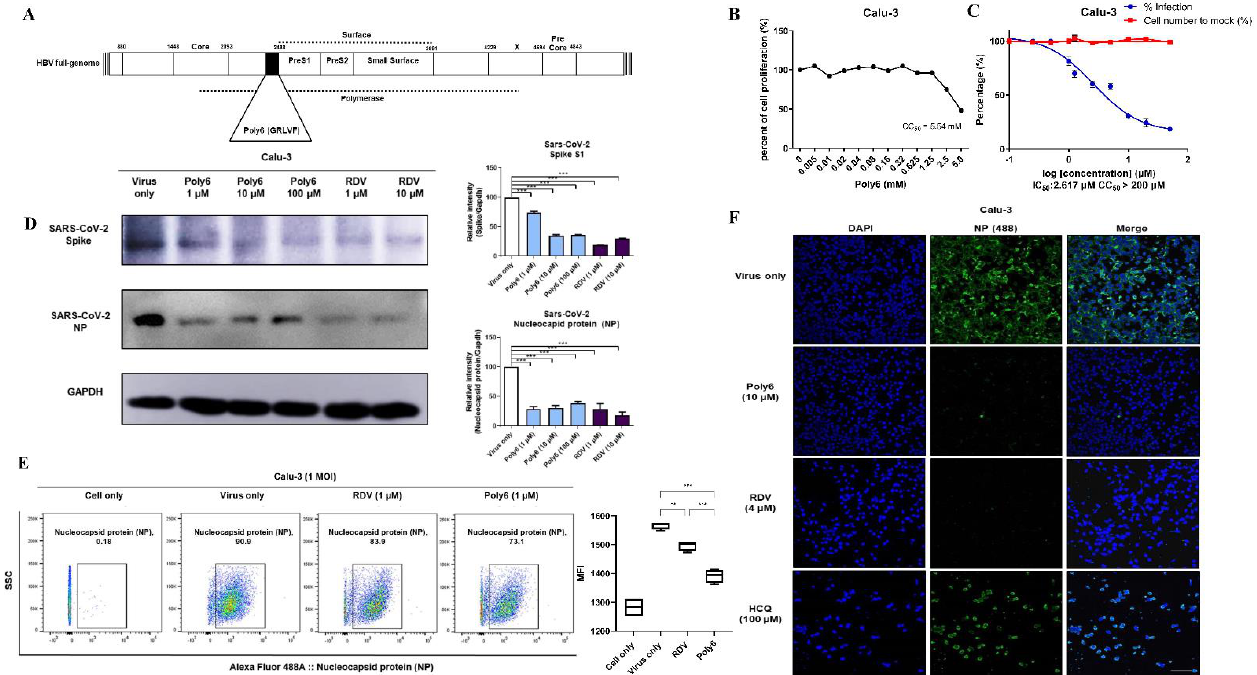
Figure 1. Poly6 inhibits SARS-CoV-2 infection in human lung cell, Calu-3 but not in Vero-E6 cells in a dose-dependent manner. ( A ) Map of Poly6 from the HBV full genome diagram in this study. Poly6 is originated from overlapping HBV polymerase gene regions corresponding to the preS1 deletion region found in patients with severe liver disease. ( B ) Calu-3 cell viability after treatment with different doses of Poly6 was measured using the MTS assay. ( C ) Percent inhibition of SARS-CoV-2 replication and cytotoxicity in Calu-3 cells. Calu-3 cells were infected in triplicate with SARS-CoV-2 at a multiplicity of infection (MOI) of 0.1 in the presence of a range of Poly6 concentrations for 72 h, and the viral replication load was measured using RT-qPCR targeting the RdRp coding region. ( D ) Western blot demonstrating SARS-CoV-2 spike protein and NP following virus infection in Calu-3 cells and inhibitory effects of Poly6 or RDV against SARS-CoV-2